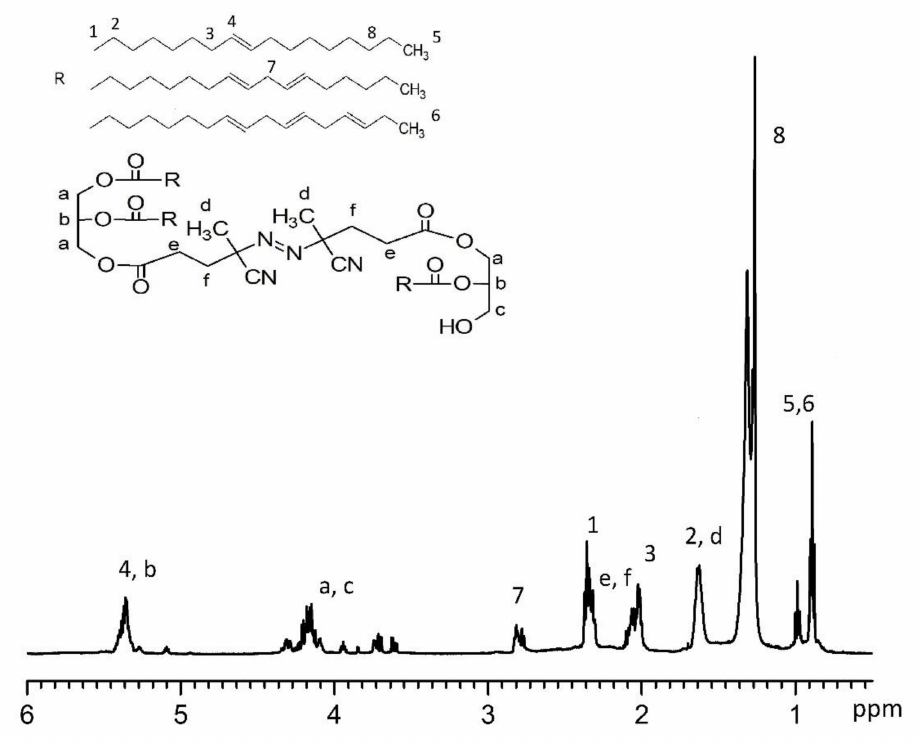
Figure 2. The 1 H NMR spectrum of